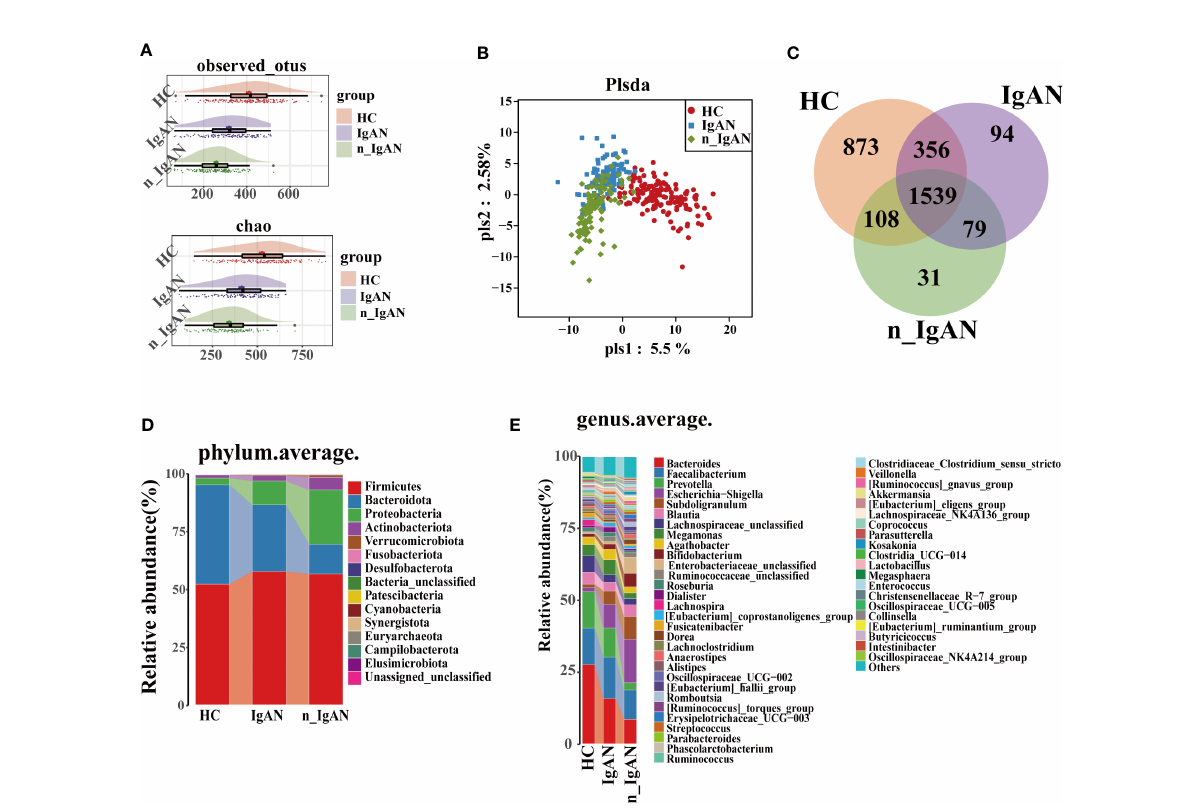
FIGURE 2 Gutmicrobiome composition differencesinHC, IgANandn_IgANgroups. (A) ObservedOTUsandchaoindexwere decreased inIgANandn_IgAN groups. (B) PLSDAgraphof gutmicrobiotacomposition. (C) AVenndiagrambasedondistributionof intestinal microbe OTUs. Atthe phylum (D) andgenus (E) levels, therewere signi fi